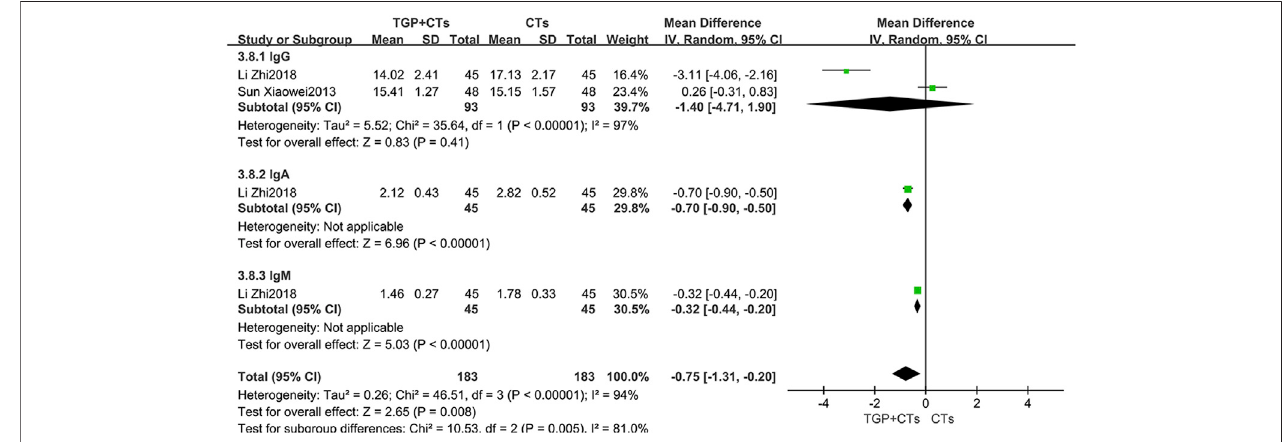
FIGURE 7 | Forest plot of IgA, IgM and IgG.